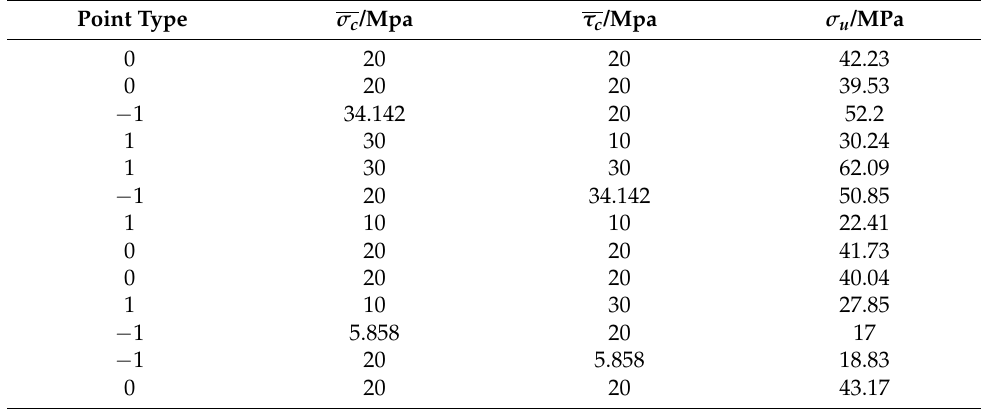
Table 9. Peak intensity of the CCD test table.